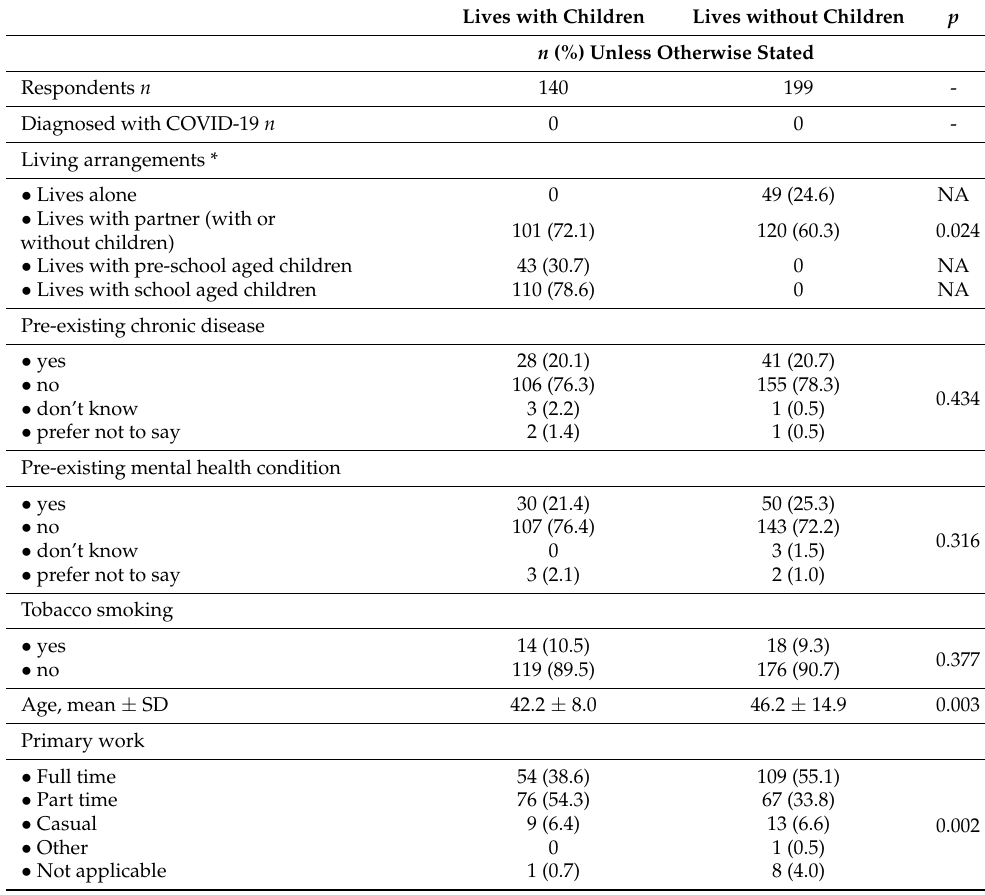
Table A2. Demographic characteristics and DASS-21 scores of female respondents residing in rural areas with or without